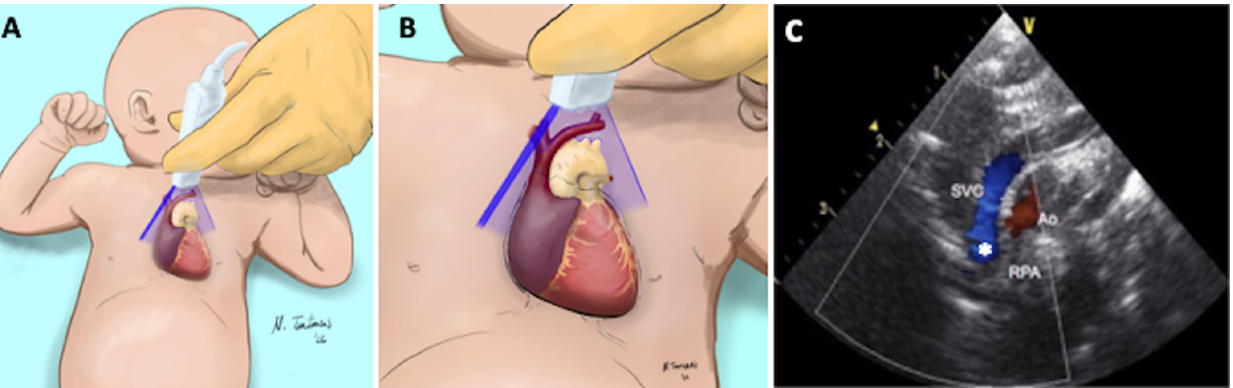
Table 2. Clinical characteristics of the cohort of